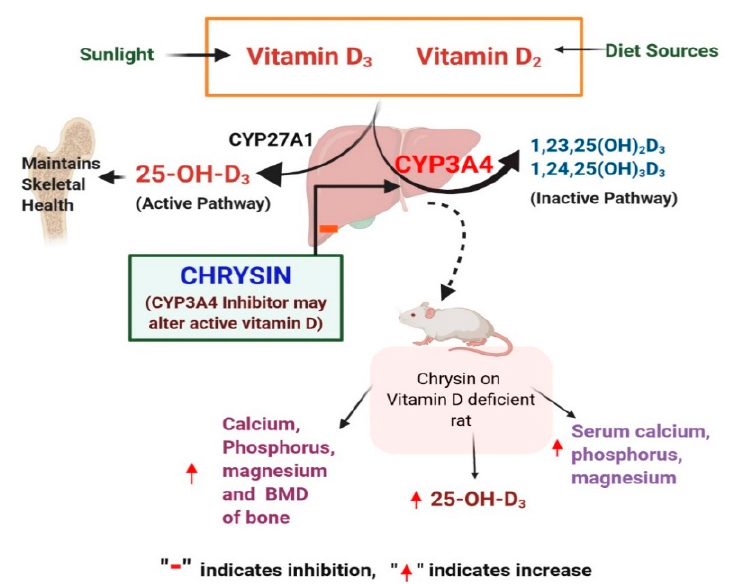
Figure 1. Chrysin CYP3A4 inhibition pathway: impact of chrysin on vitamin D and bone health.